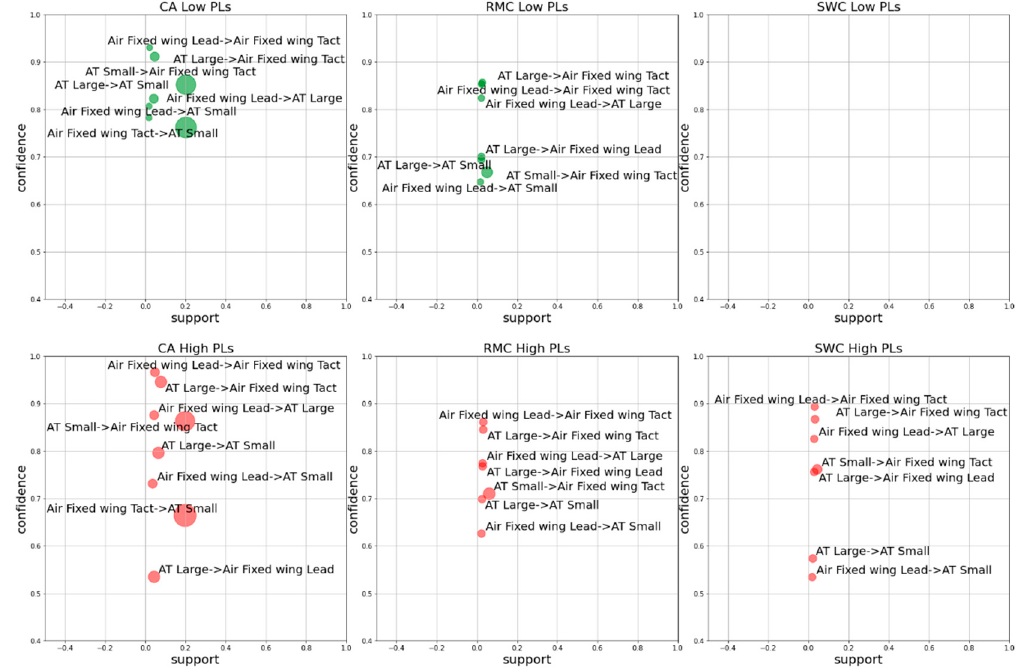
Figure 8. Association rules (support >1% and confidence >50%) between fixed ‐ wing aerial resource (included airtankers) subcategories for daily assignments in three GACCs at two PL levels. AT Large: large airtanker; AT Small: small airtanker; Lead: lead plane; Tact: tactical plane.